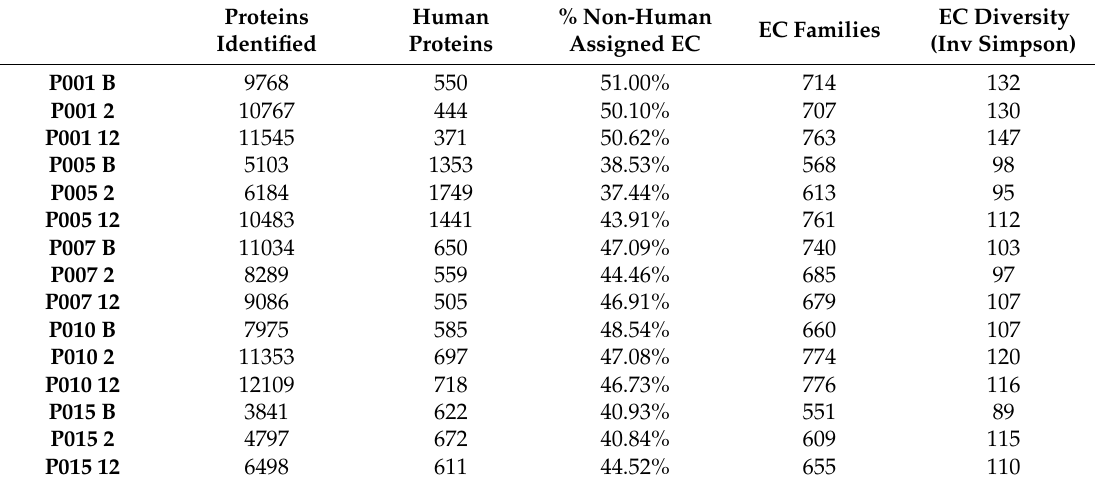
Table 5. Proteomics results and their